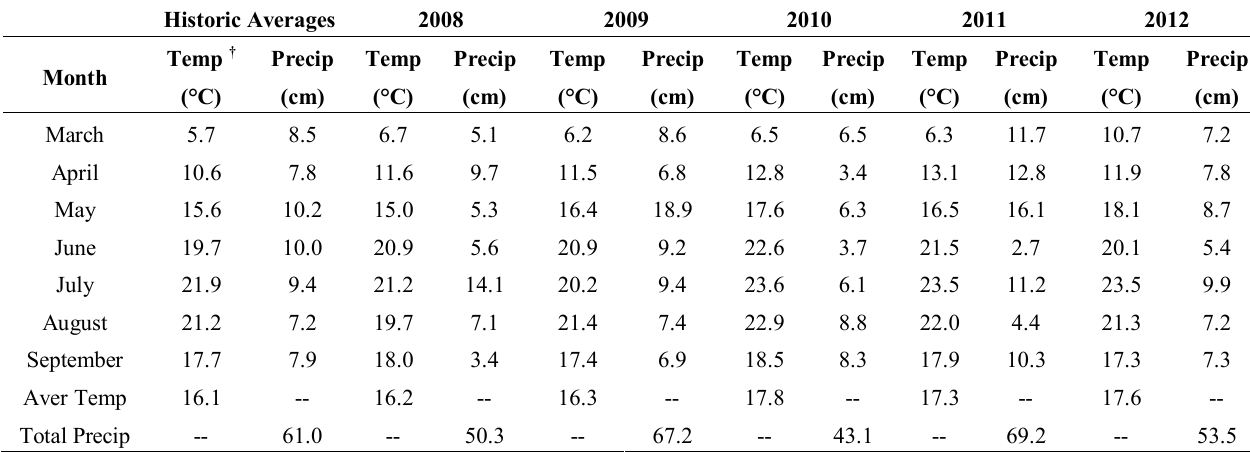
Table 2. Historic and monthly average temperatures and total precipitation for March through September 2008 through 2012 in the Kentland Farm